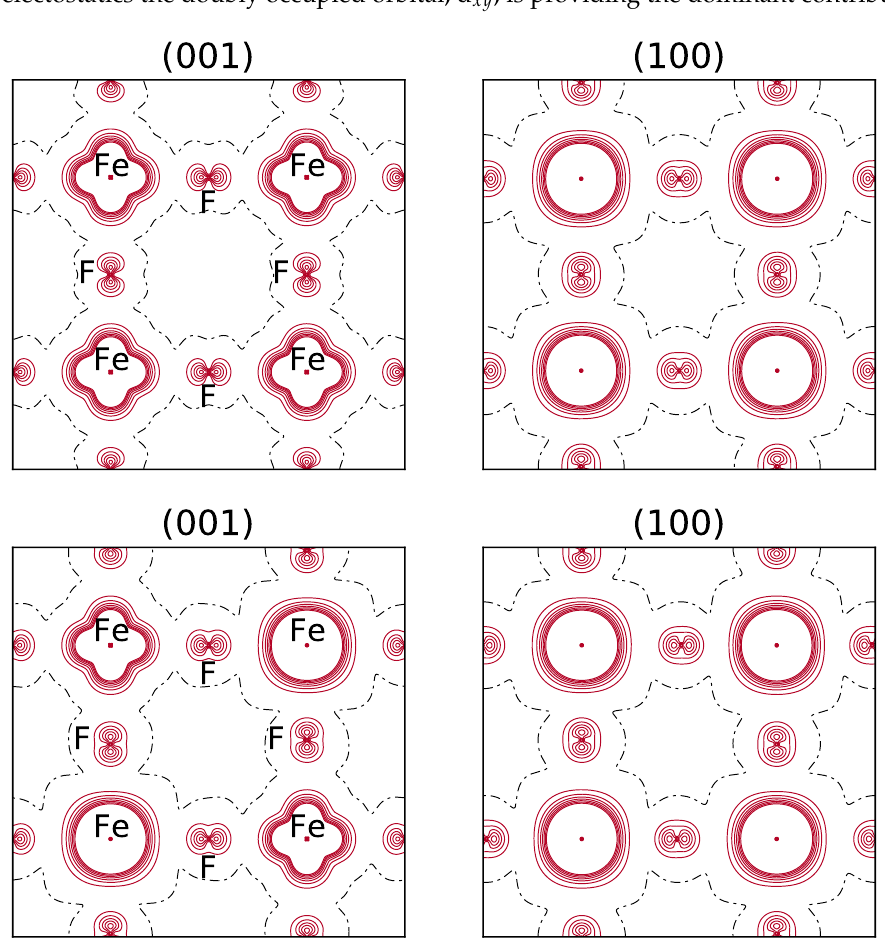
Figure 3. Top : B3LYP spin density maps of the primitive cell in the xy ( left ) and xz ( right ) planes. FM solution. The d xy orbital is doubly occupied. Bottom : the spin density function for the most stable configuration of the (044) composition (see the top left panel in Figure 1 for the occupancy of the d orbitals of the 8 Fe atoms). The separation between contiguous isodensity lines is 0.01 | e | a − 3 ; the 0 function is truncated in the core region at ± 0.08 | e | a − 3 . Continuous, dashed and dot-dashed lines 0 correspond to positive, negative and null values of the spin density,